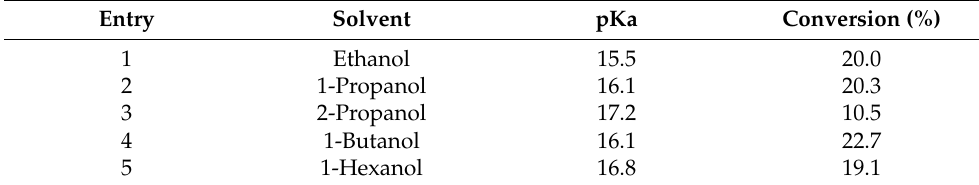
Table 2. Effect of solvent type on catalytic performance a .